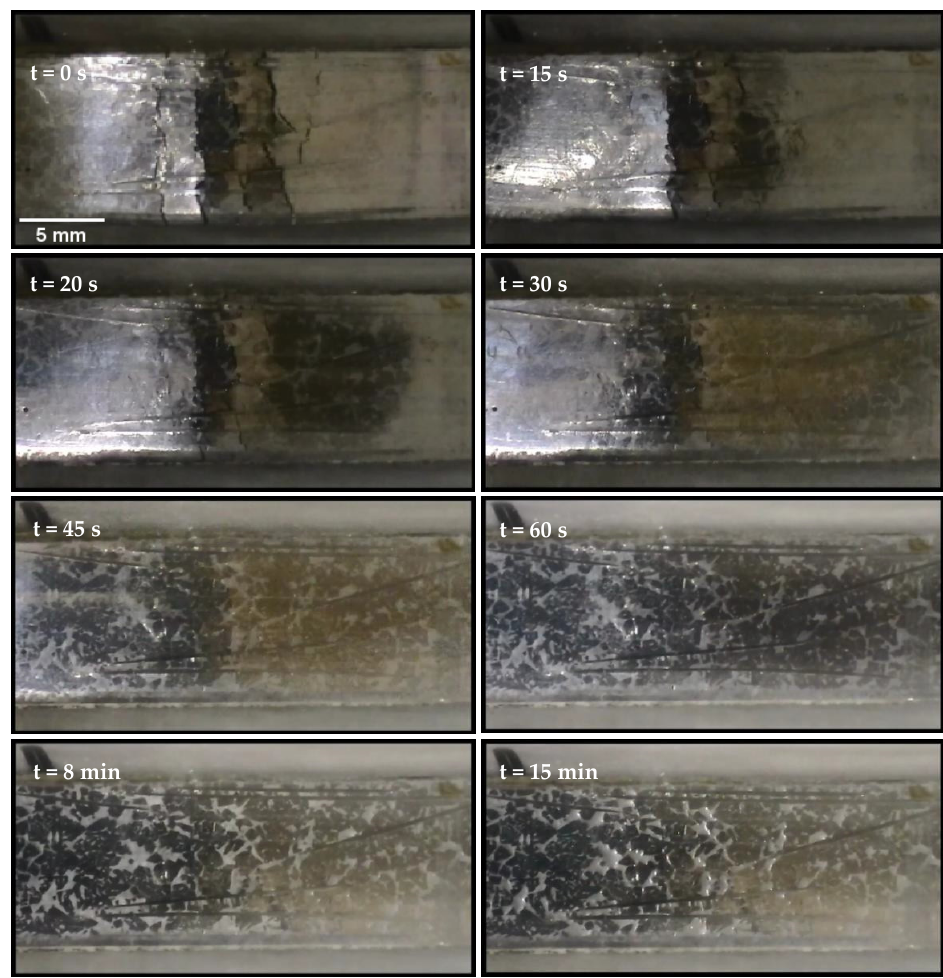
Figure 8. Healing of microstructure in Bi-20% Sn. In the later stages, the molten eutectic phase can be seen to sink in the last stage. This fills any internal cracks in the matrix. Reprinted/adapted with permission from Ref. [20]. 2013, Shobhit Misra.